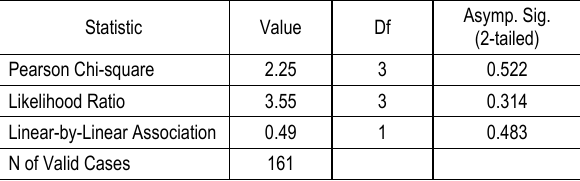
Table 11. Ethnic background versus risk